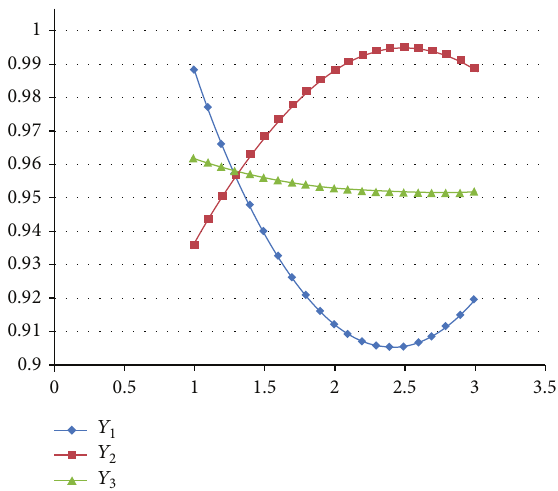
Figure 3: The changed weights affecting 𝑌 1 , 𝑌 2 , and 𝑌 3